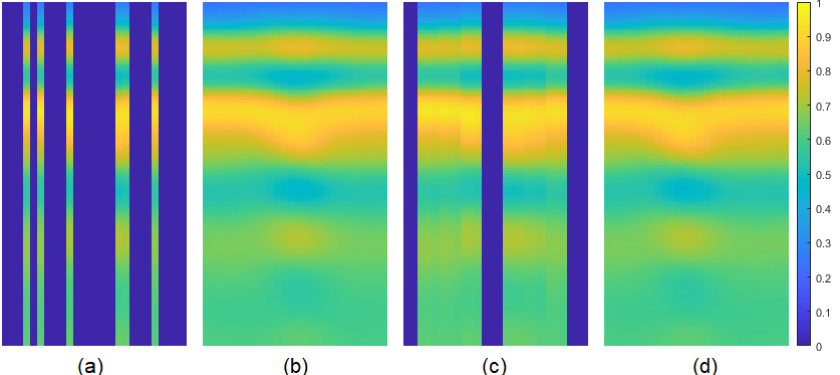
Figure 19. 80% column-wise missing data case for the zoomed target (third one) of real data-I: ( a ) GPR image with missing entries, ( b ) original GPR image, recovered images by ( c ) NNM zoomed , ( d ) DIP zoomed .